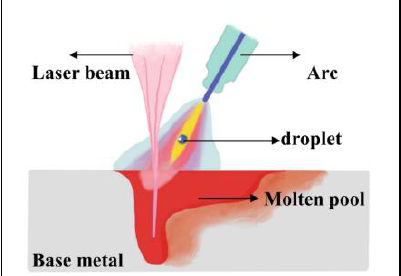
Figure 3. Schematic diagram of LAHW theory.